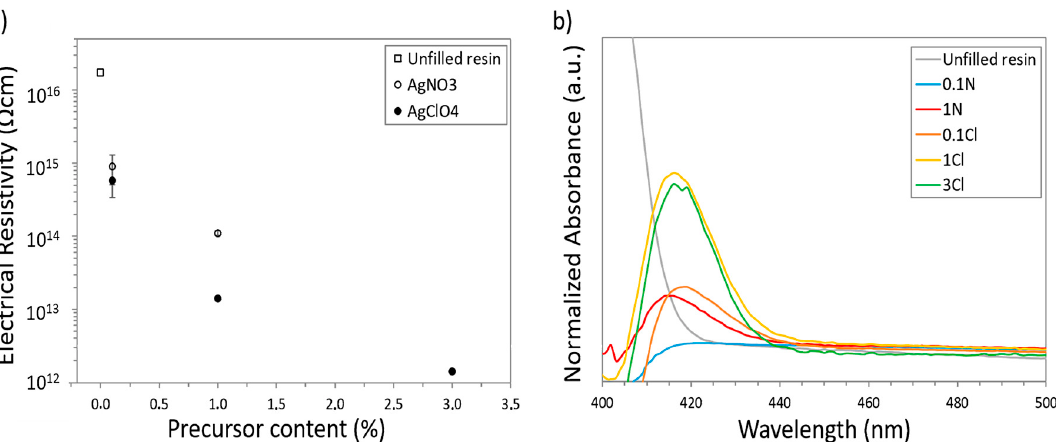
Figure 4. ( a ) Electrical resistivity and ( b ) UV-Vis spectra of the different Ag nanocomposites after the post-curing